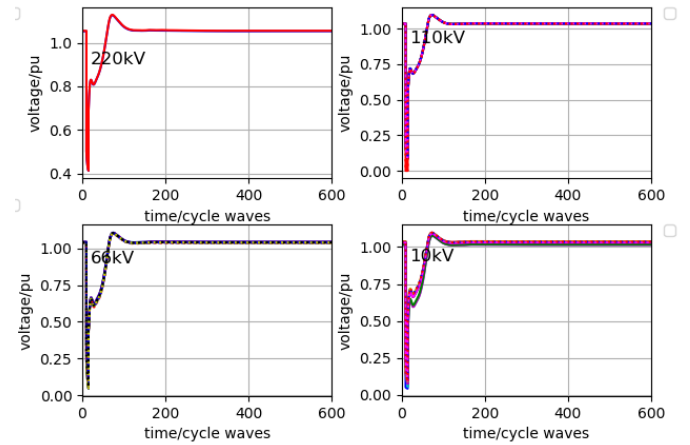
Figure 13. Fault 4 Action 241: Bus positive sequence voltages after SVG compensates 30 Mvar, 60 Mvar, 60 Mvar, 50 Mvar and 50 Mvar, respectively.